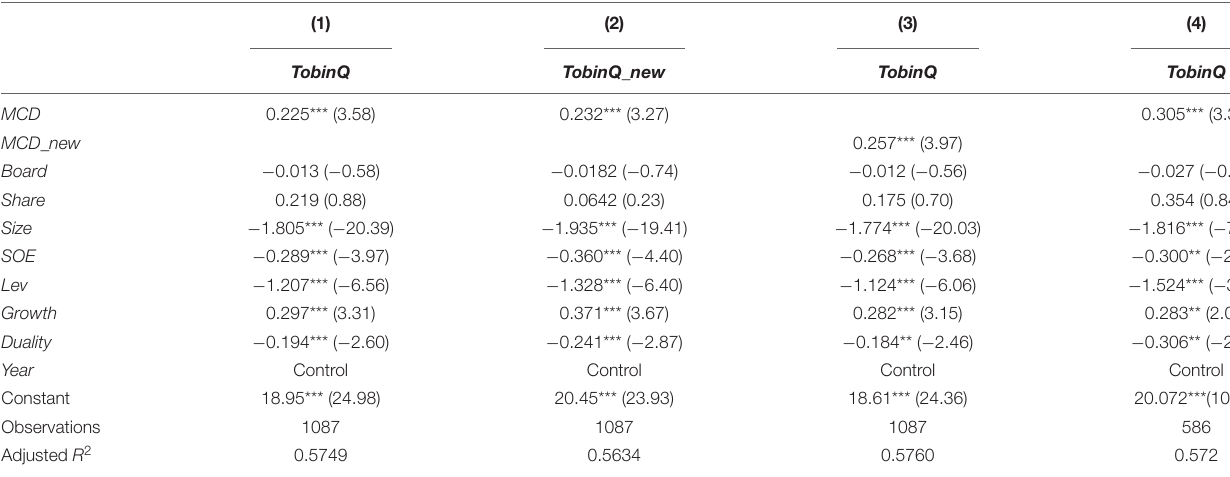
TABLE 5 | Results for multiple regression